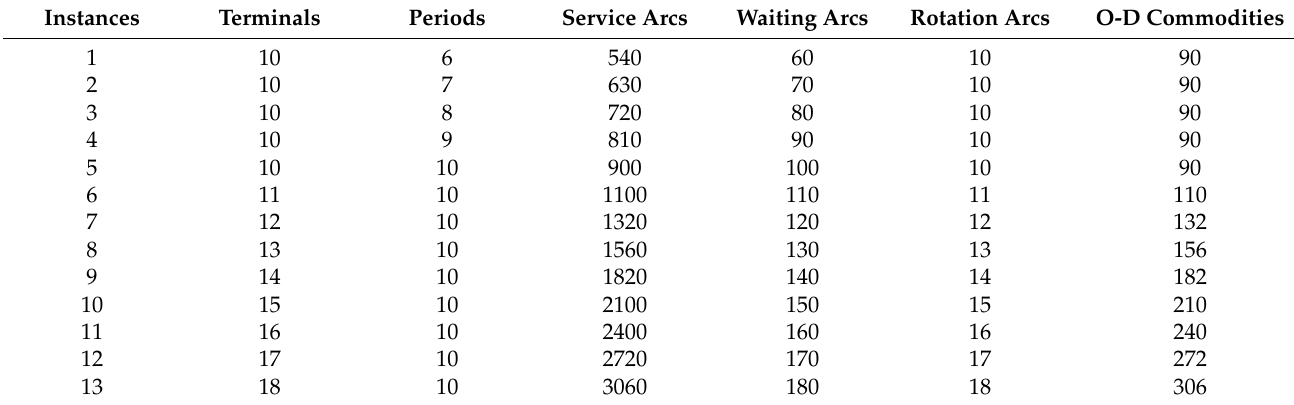
Table 1. Dimensionality of the middle-scale instances.